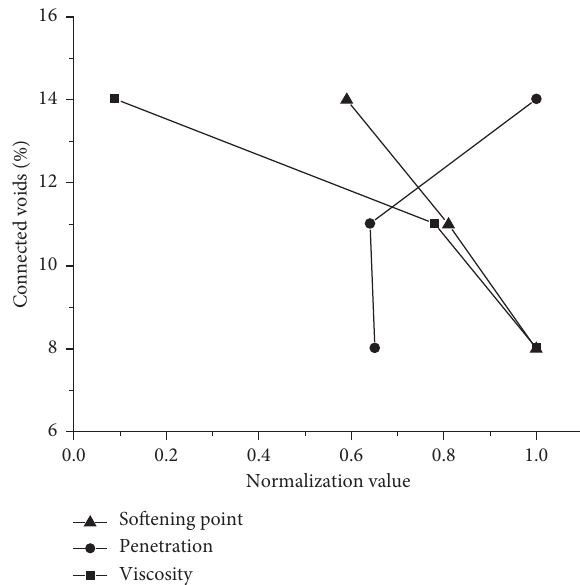
Figure 4: The relation between asphalt index and connected